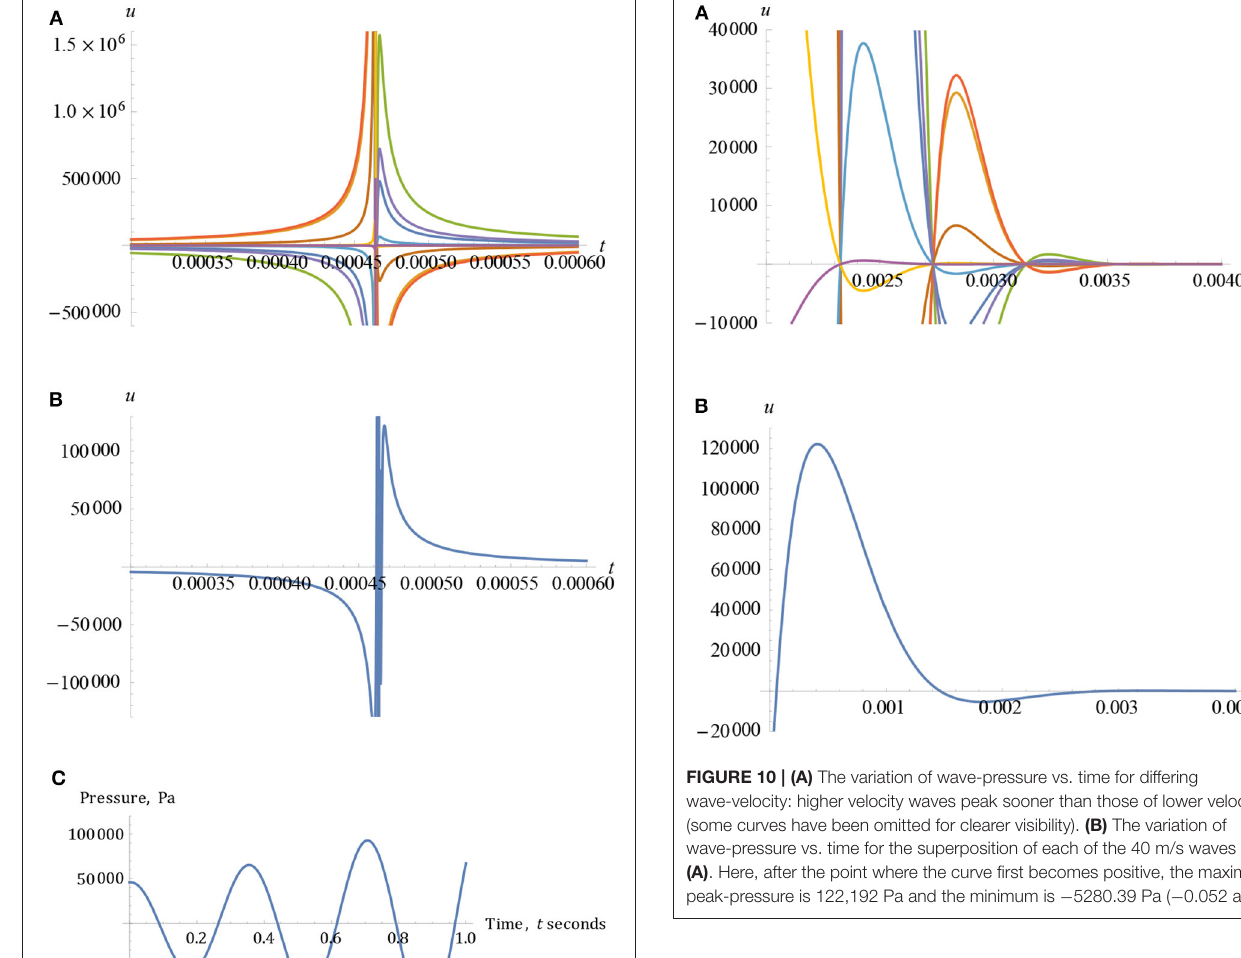
5280.39 Pa ( 0.052 − −